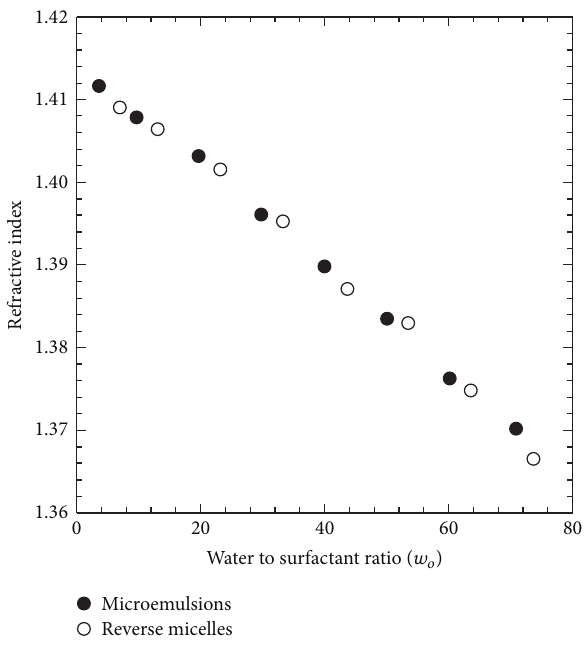
Figure 6: Refractive indices of CTAB/1-butanol/cyclohexane/water microemulsions and CTAB/1-butanol/water reverse